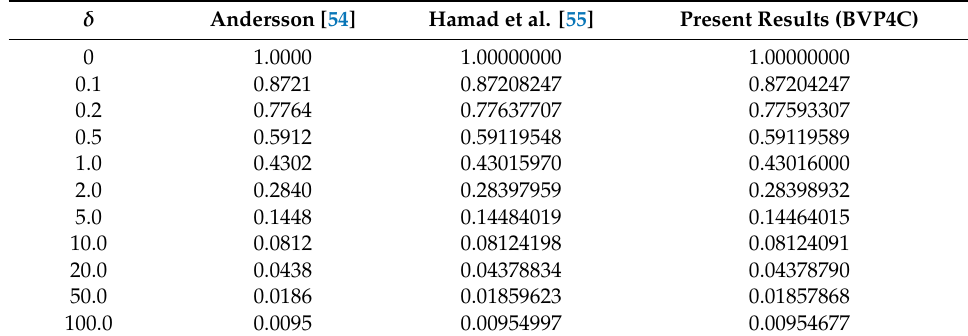
Table 2. Comparison of skin friction f (cid:48)(cid:48) ( 0 ) for δ when Me = M = h 2 = h 4 = h 6 = h 8 = γ = Nb = Nt = Ec = Sc = Pe = Sb = 0,Pr = 1.